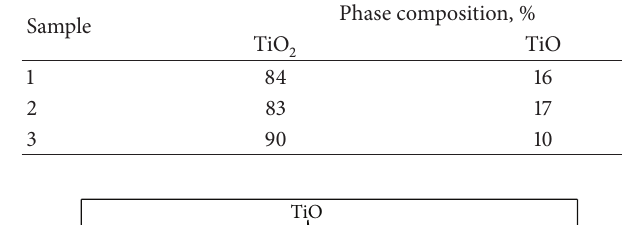
Table 1: Phase composition of the deposited thin Ti 𝑥 O 𝑦 films.